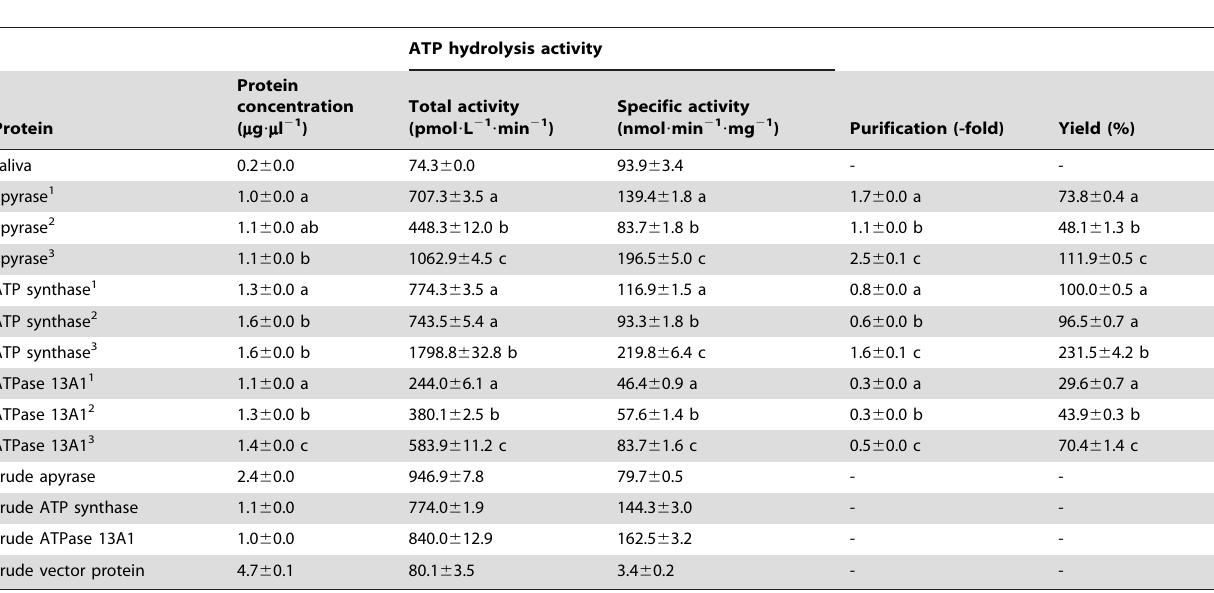
Table 1. Comparison of the ATP hydrolysis activities of purified apyrase, ATP synthase and ATPase 13A1 from E. coli .*